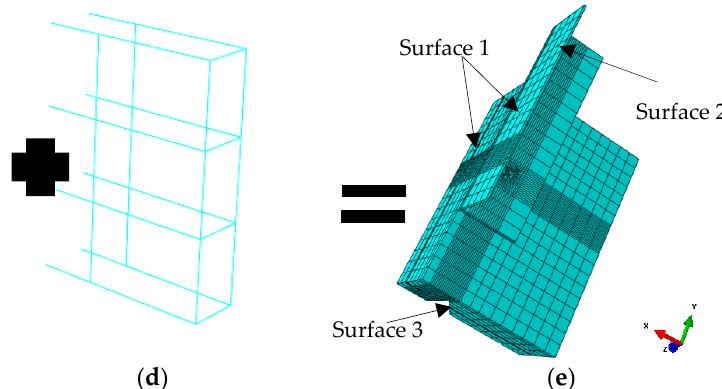
Figure 9. Finite element (FE) analysis model: ( a ) concrete; ( b ) steel beam; ( c ) high-strength bolt; ( d ) steel cage; ( e ) model.